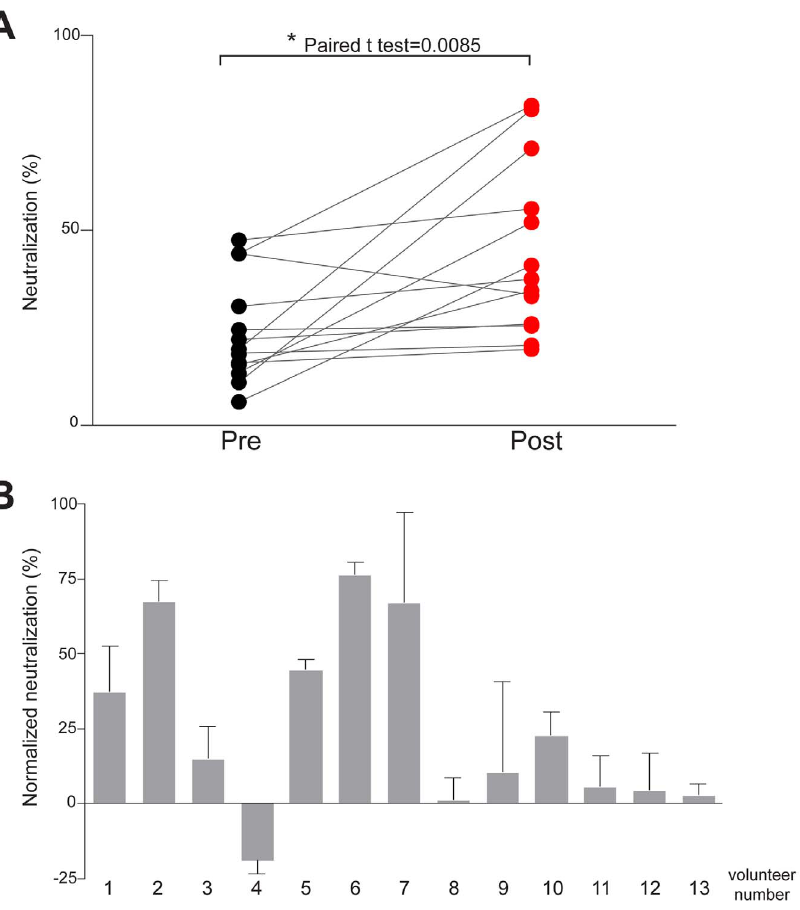
Figure 1. Human antisera neutralizes heterologous 1a infectivity in cell culture. Pre or post vaccination sera were incubated with chimeric H77C/JFH-1 HCVcc followed by infection of naı¨ve huh7.5 cells. Representatives of two independent experiements performed in triplicates are shown. The number of infected cells was quantitated by immunostaining using anti-NS5A antibodies 48 hour post-infection. (A) Neutralization activity was calculated using a negative control lacking serum (0%) and anti-CD81 antibody as a positive control (%). ‘‘Pre’’ sera were collected prior to vaccination and ‘‘post’’ sera were collected 2 weeks post-third immunization [33]. Grey line connects the neutralization activity of pre- and post- vaccination of the same volunteer. The paired t test score of mean neutralization activity between pre- and post-groups is shown indicating a significant difference. (B) Neutralization activity of post-vaccination sera was normalized using pre-vaccination sera of the same individual. The neutralization activities of three volunteers’ sera within this group were not shown due to inconsistent results from two independent experiments.